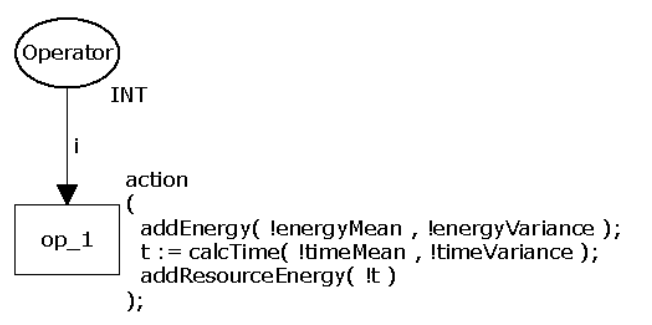
Figure 3. Generic CPN model of the nesC